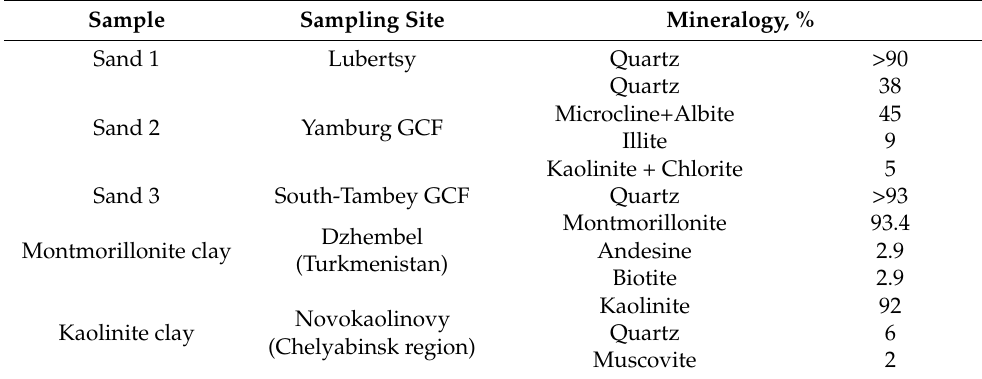
Table 1. Lithology and mineralogy of samples.